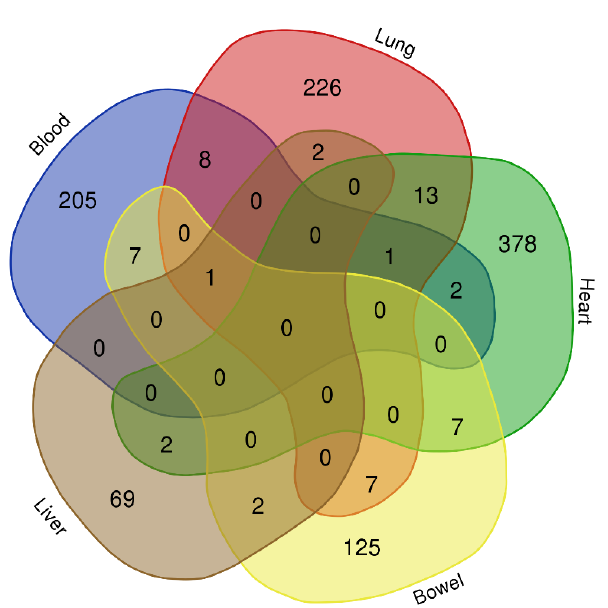
Figure 2. Genes differentially expressed between SARS-CoV-2-infected and control samples. ( A ) PCA of COVID-19 and control samples from blood and lung tissues. Red and blue ellipses represent COVID-19 and control samples, respectively. ( B ) Heatmap of the DEGs in blood and lung tissues. COVID-19 and control samples are shown in salmon and turquoise colors, respectively. Each row corresponds to a DEG. The upregulated and downregulated genes are indicated by red and blue colors, respectively. A dendrogram depicting hierarchical gene clustering (based on Z-scoring) is shown on the left.